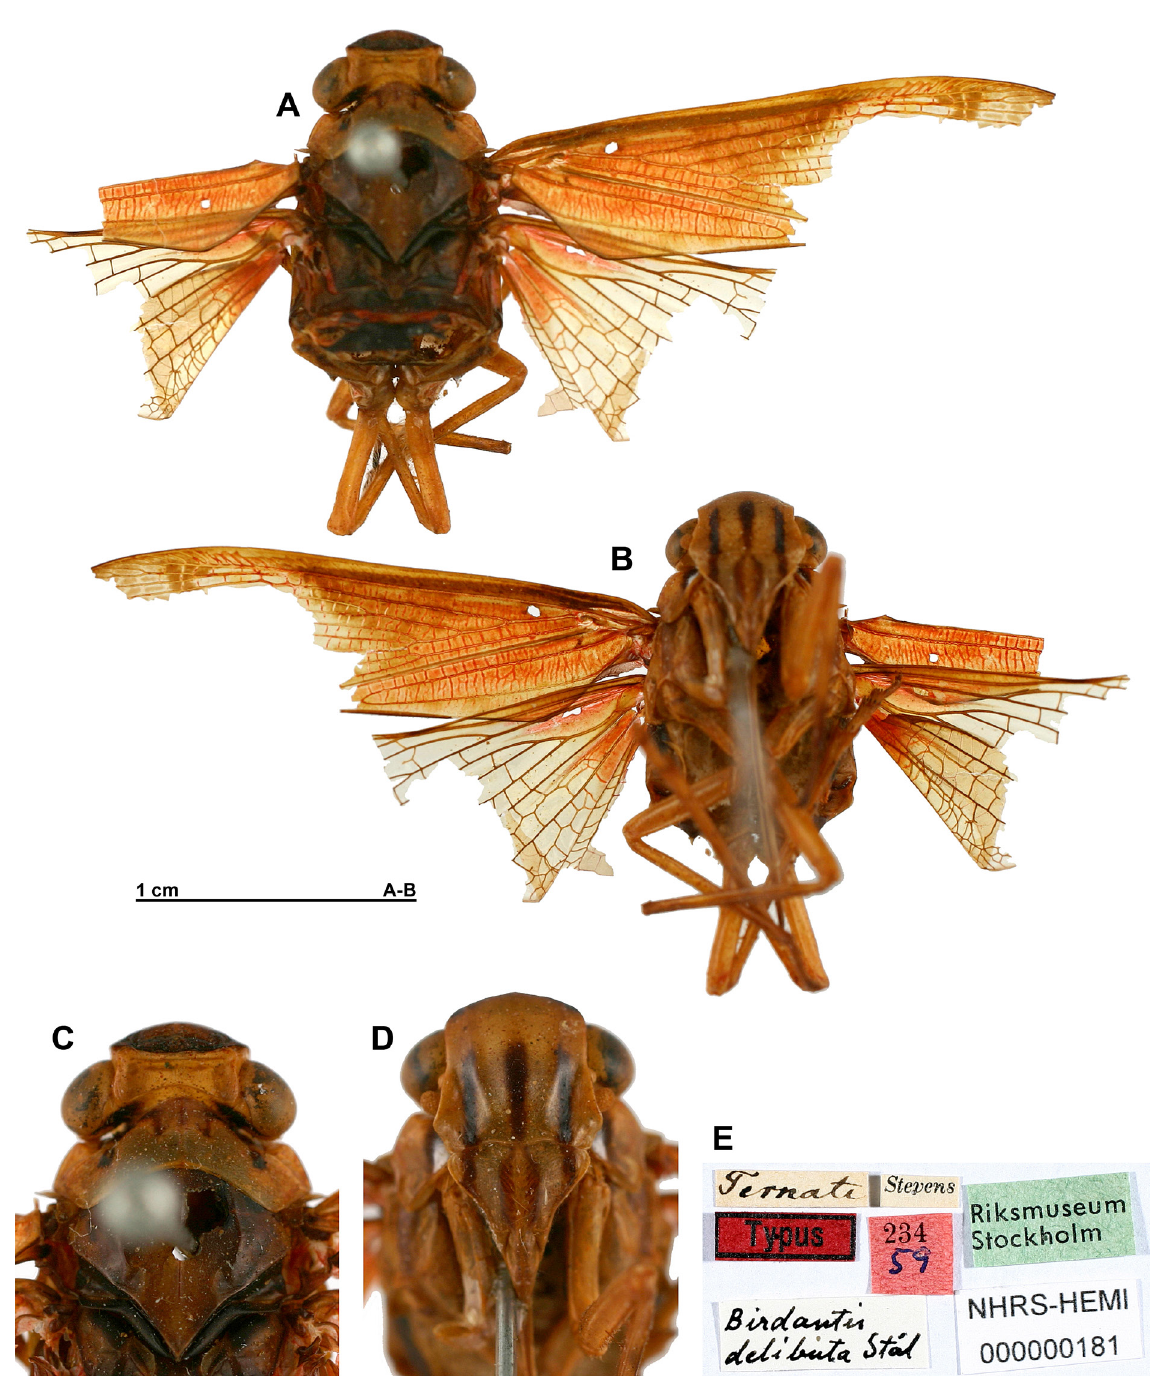
Fig. 6. Birdantis delibuta Stål, 1863, holotype. A . Habitus, dorsal view. B . Habitus, ventral view. C . Head and thorax, dorsal view. D . Head, normal view of frons. E . Labels. C–E not to